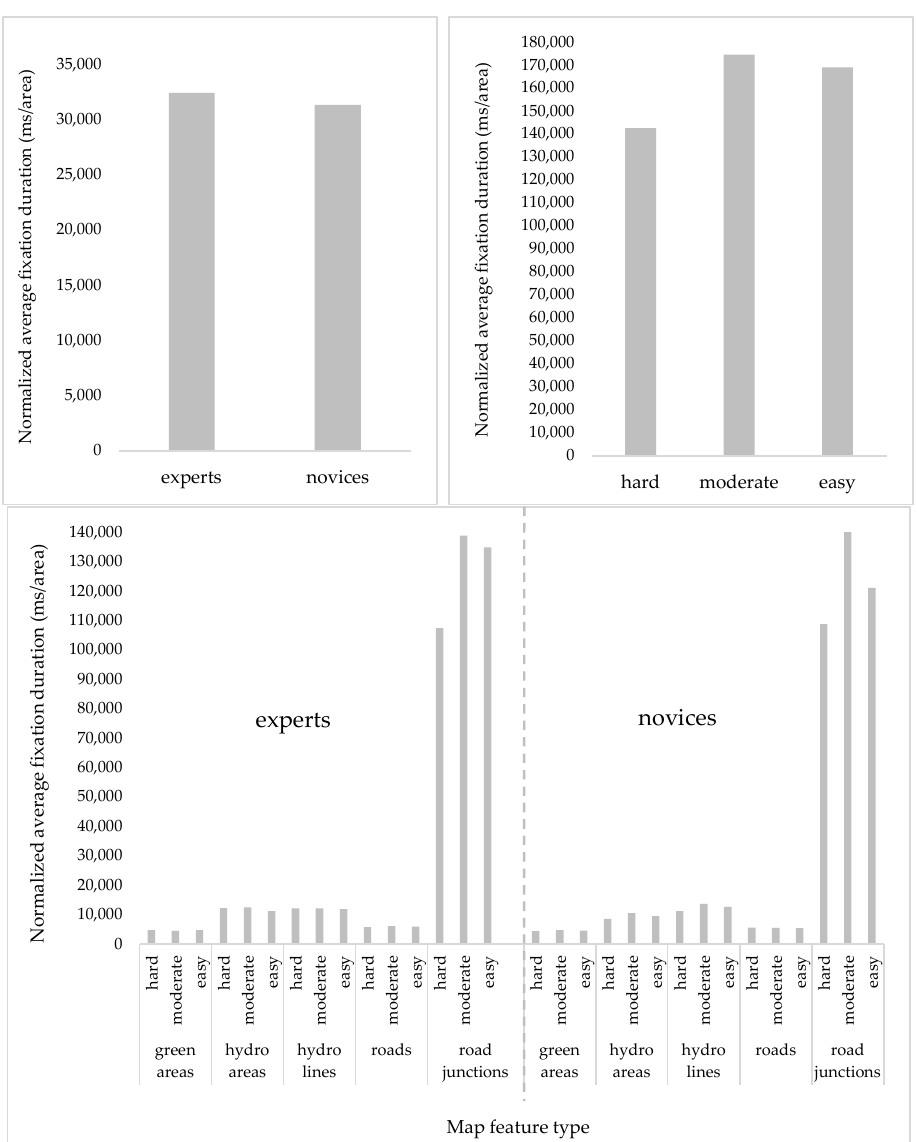
Figure 6. Descriptive statistics of normalized differences in average fixation durations (ms/area) within- vs. outside-AOIs. ( Top left ): Aggregated by expertise , ( Top right ): Aggregated by task difficulty , ( Bottom ): Aggregated by map feature type . Inferential analyses are presented in Tables 2 and 3.